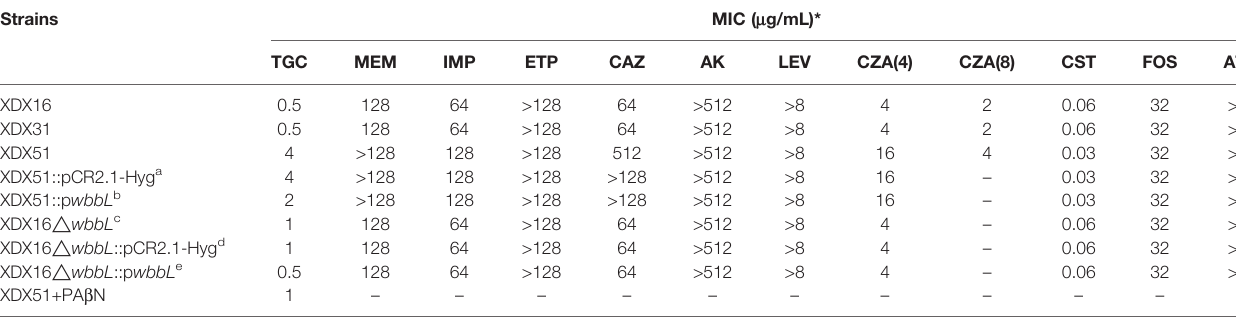
TABLE 1 | Antimicrobial susceptibility of isolates used in the study. Strains